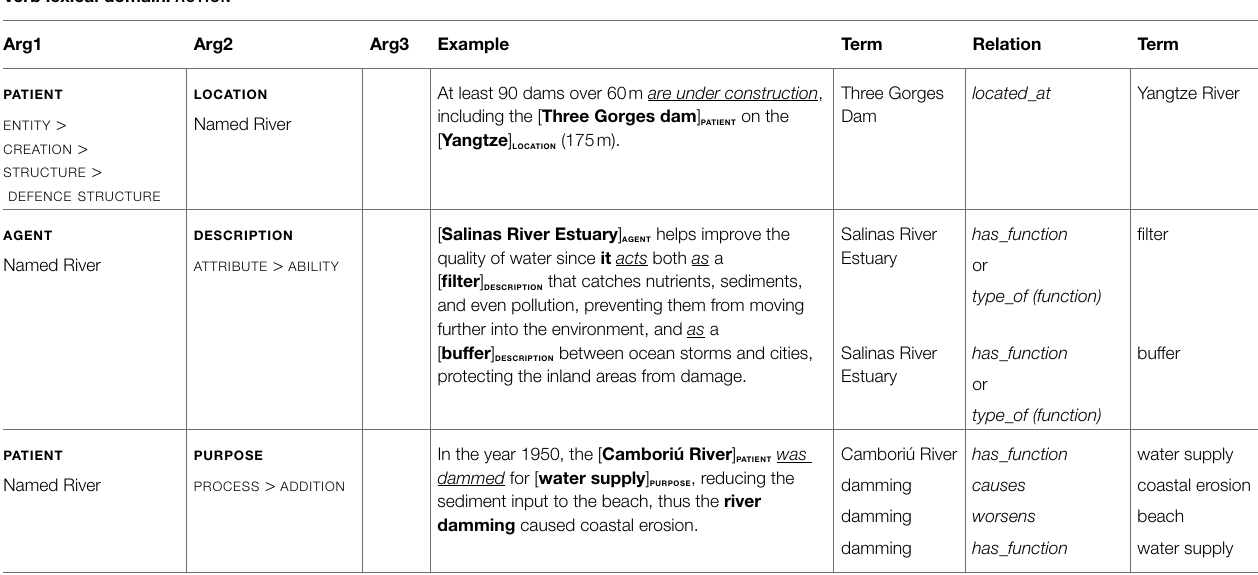
TABLE 8 | Results from the semantic annotations for the lexical domain of action . Verb lexical domain: